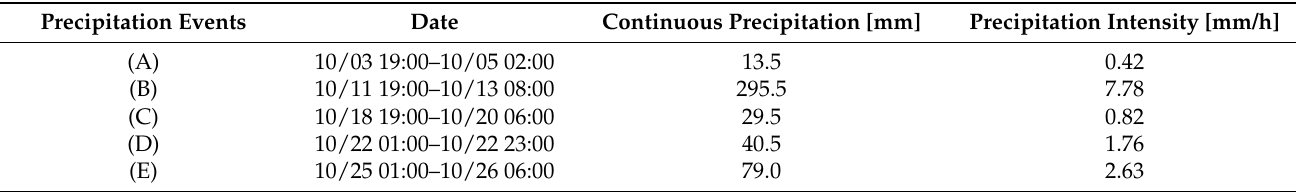
Table 4. Continuous precipitation and precipitation intensity of major precipitation events observed in October 2019. Items of precipitation events correspond to Figure